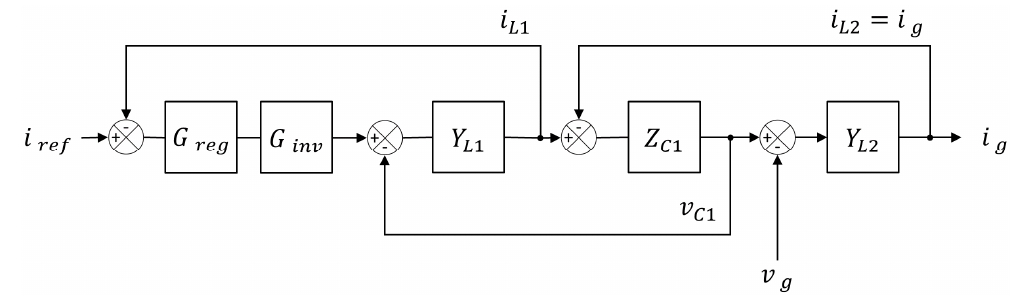
Figure 5. Block diagram of the current control loop of the VSI.